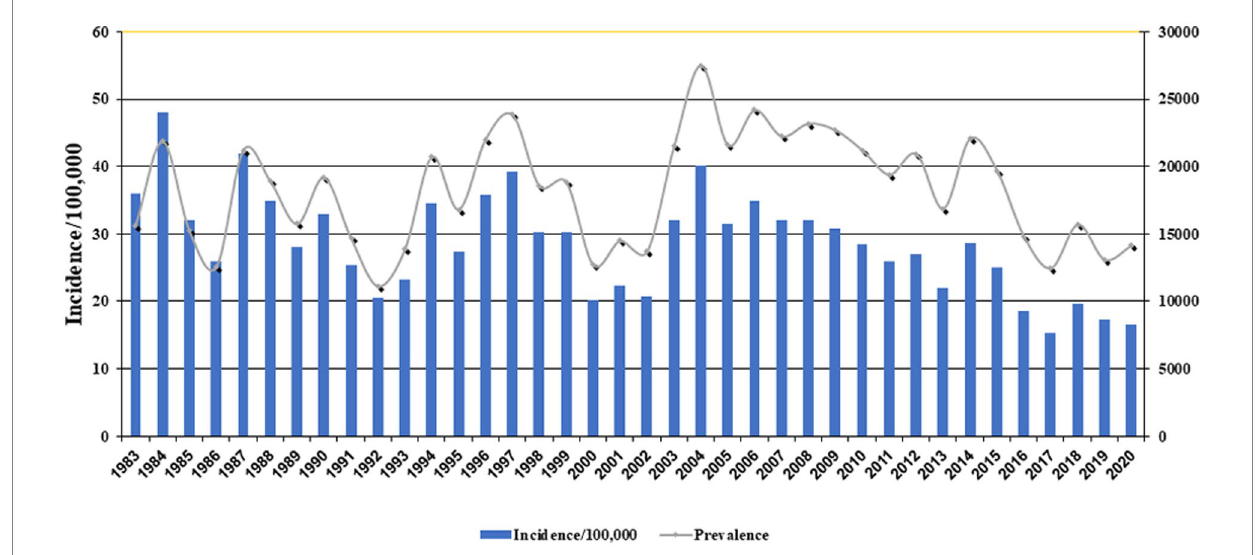
FIGURE 1 Incidence and prevalence rates of cutaneous leishmaniasis in Iran,